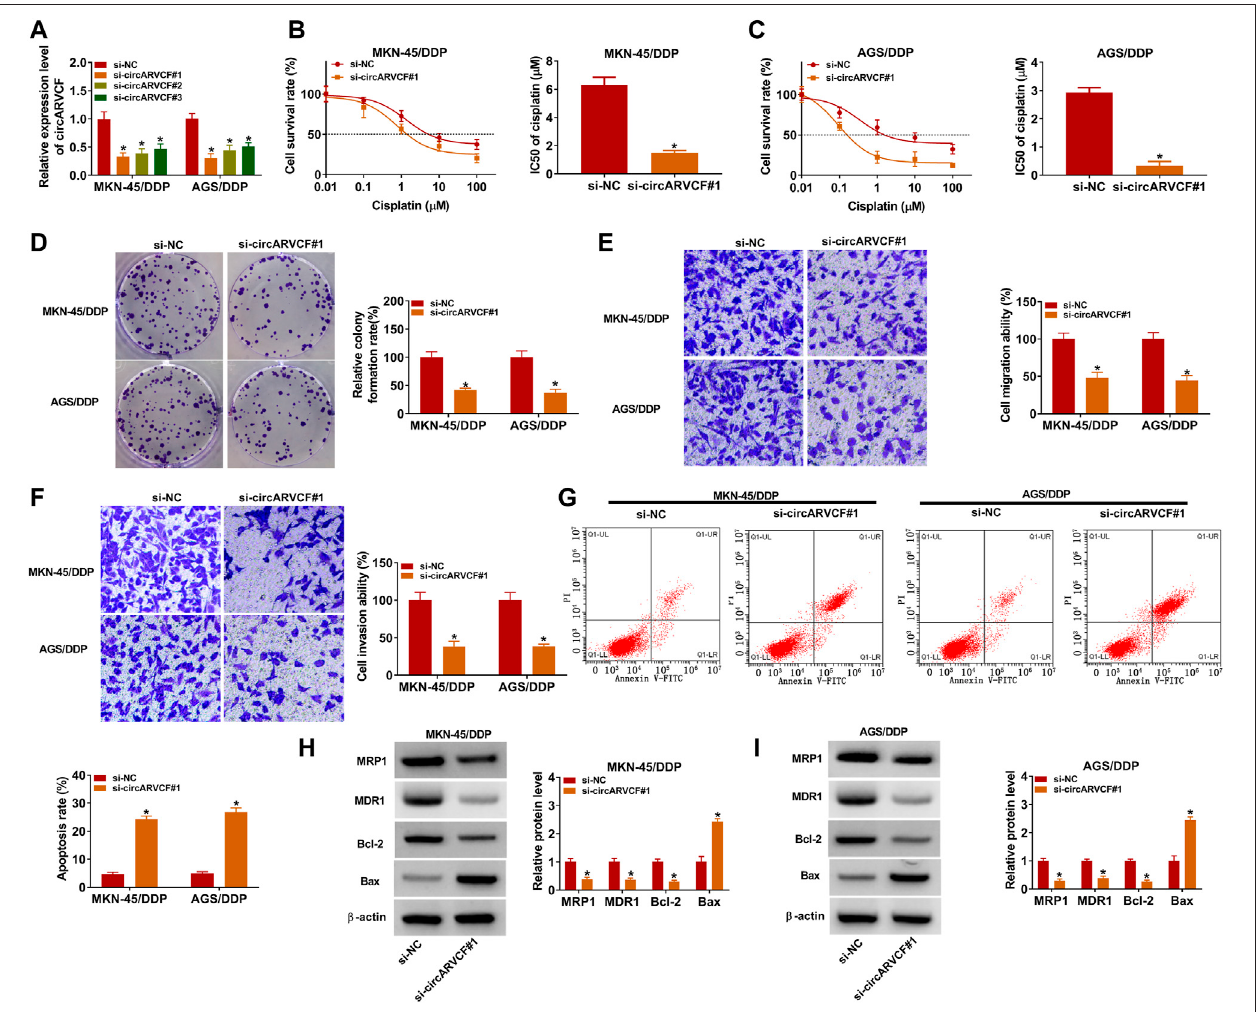
FIGURE2| CircARVCF knockdown suppressedDDPresistanceinDDP-resistantGCcells. (A) TheexpressionofcircARVCFinMKN-45/DDPand AGS/DDPcells transfectedwithsi-circARVCF#1,si-circARVCF#2,si-circARVCF#3,orsi-NCwasdetectedbyqRT-PCR. (B – I) MKN-45/DDPandAGS/DDPcellsweretransfectedwith si-NC or si-circARVCF#1. (B,C) IC50 of cisplatin in MKN-45/DDP and AGS/DDP cells was examined with CCK-8 assay. (D) The colony formation of MKN-45/DDP and AGS/DDPcellswasevaluatedbycolonyformationassay. (E,F) ThemigrationandinvasionofMKN-45/DDPandAGS/DDPcellsweretestedbytranswellassay. (G) The apoptosis of MKN-45/DDP and AGS/DDP cells was analyzed by fl ow cytometry analysis. (H,I) The protein levels of MRP1, MDR1, Bcl-2 and Bax in MKN-45/DDP and AGS/DDP cells were measured via western blot assay. * p < 0.05.